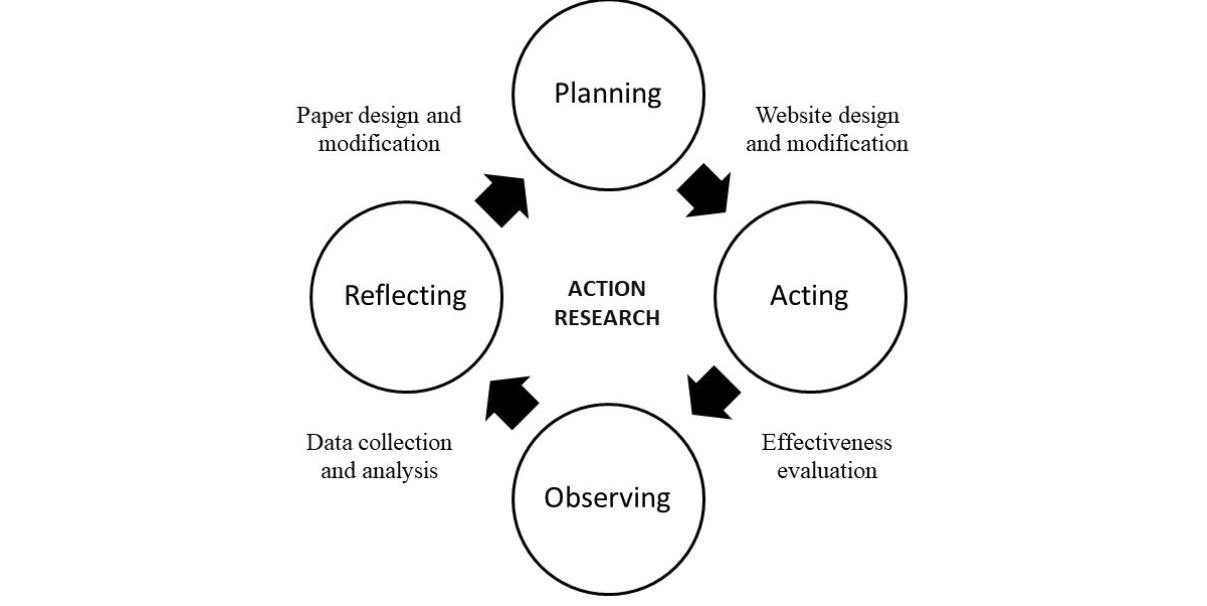
Figure 1. The process of action research in developing web-based shared decision-making regarding fertility